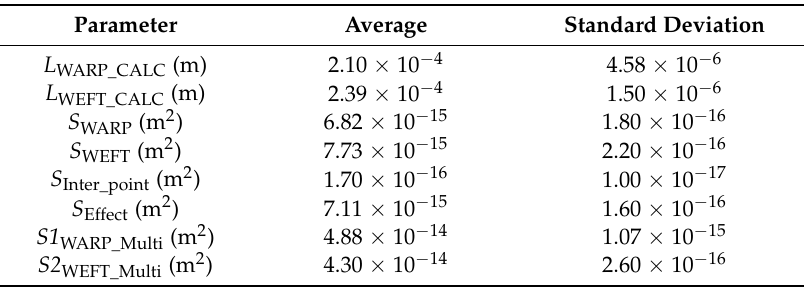
Table 13. The modeling results for RSKCu+Ni.